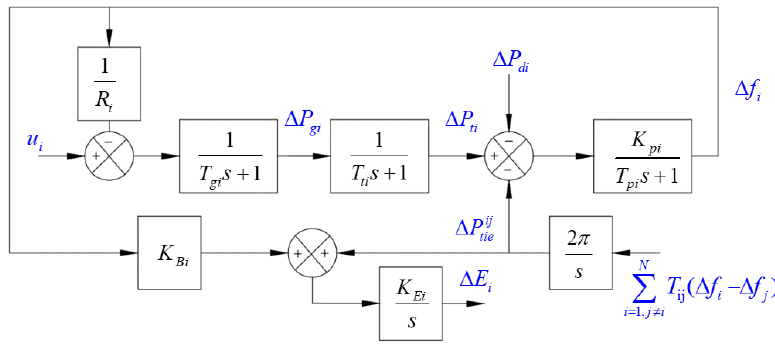
Figure 1. The simple block chart of the i th area of a multi-area power network.